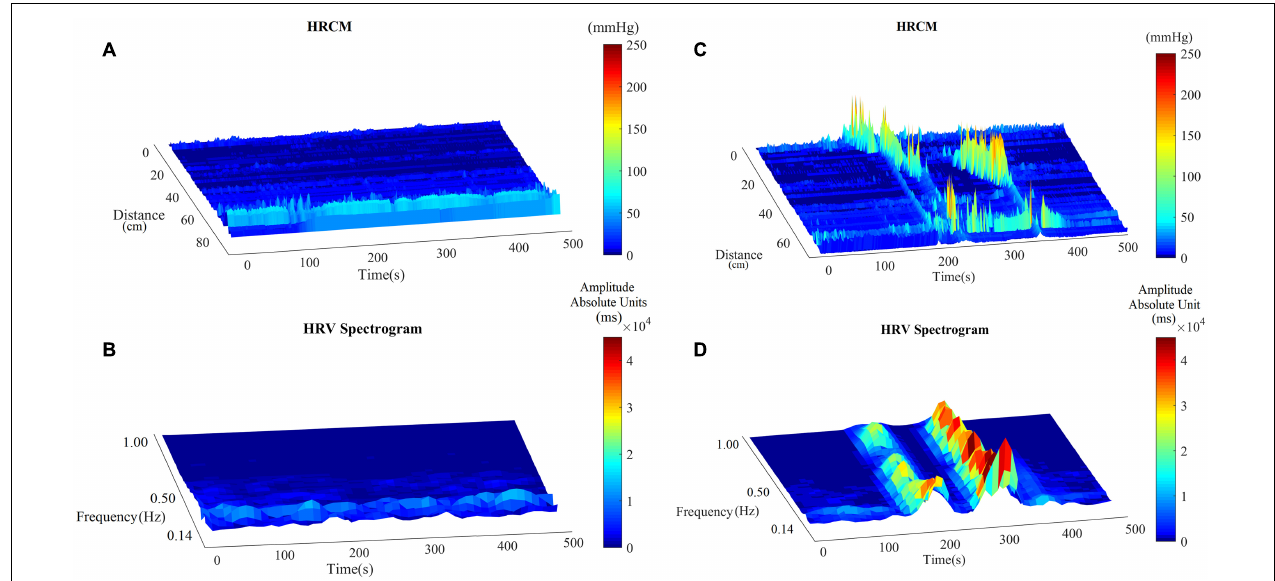
FIGURE 4 | The RSA band in baseline and with HAPWs. (A) Baseline HRCM recording without any colonic motor pattern. (B) HF power/RSA band during the baseline. (C) HRCM recording with Motor Complex. (D) HF power/RSA band during the Motor